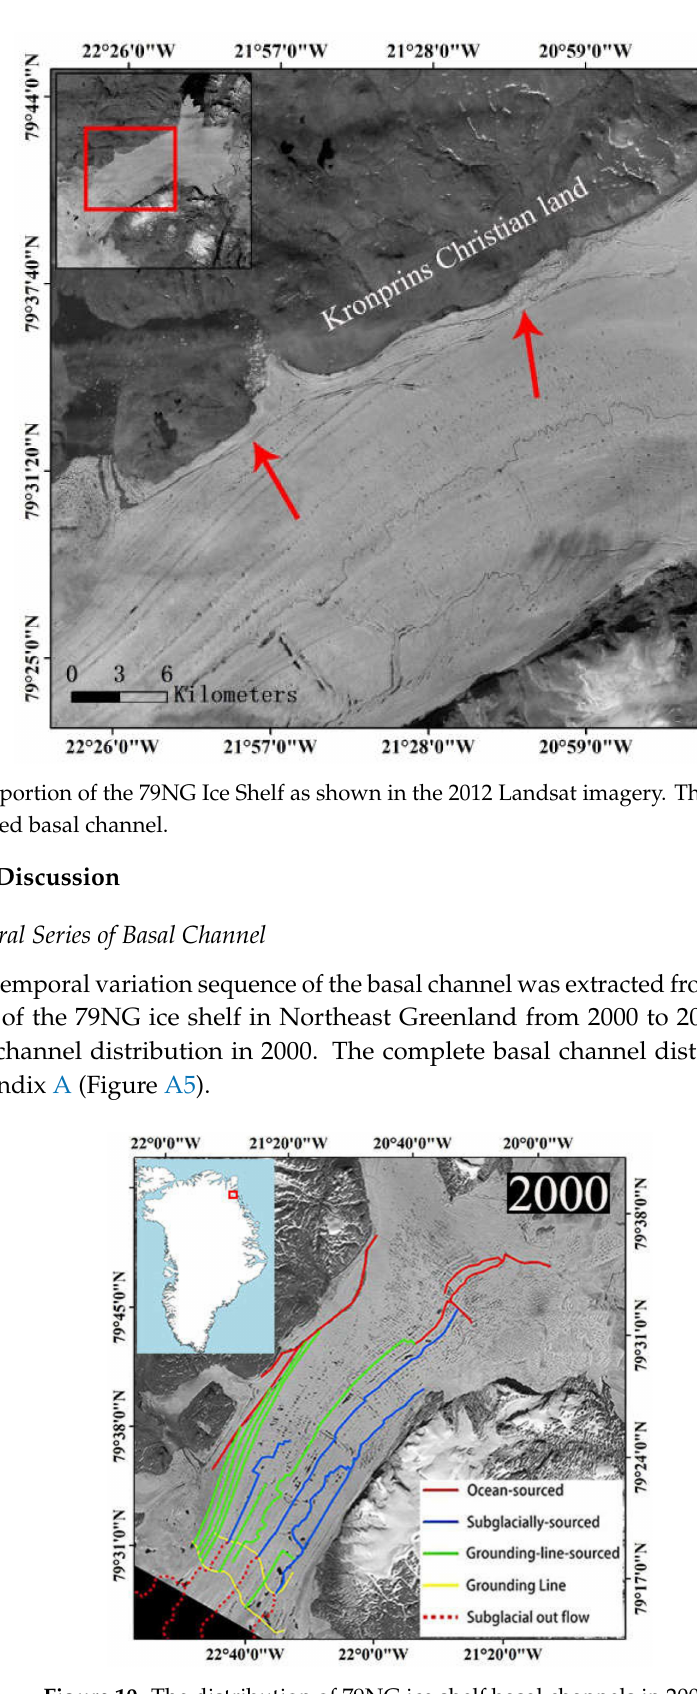
Figure 10. The distribution of 79NG ice shelf basal channels in